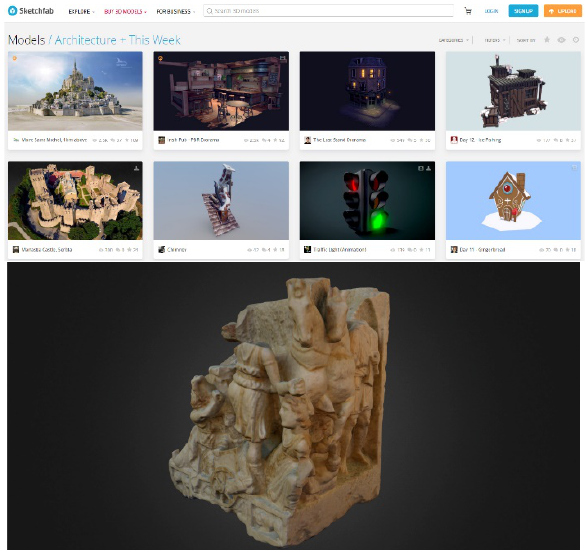
Figure 6: Sketchfab platform, in which the digital models are the most disparate, grouped without criteria, and in the absence of the information necessary for the understanding of the detected